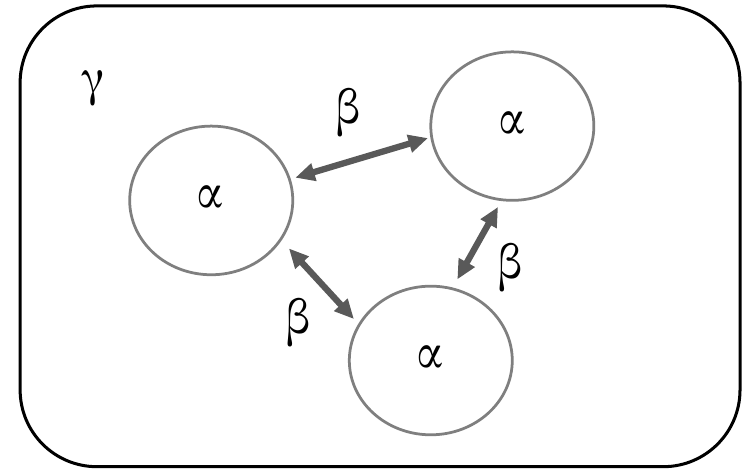
Figure 4. Partitioning diversity according to landscape scale. Gamma diversity is the total diversity of the landscape. Alpha diversity is the diversity within sub-communities. Beta diversity is the diversity between the